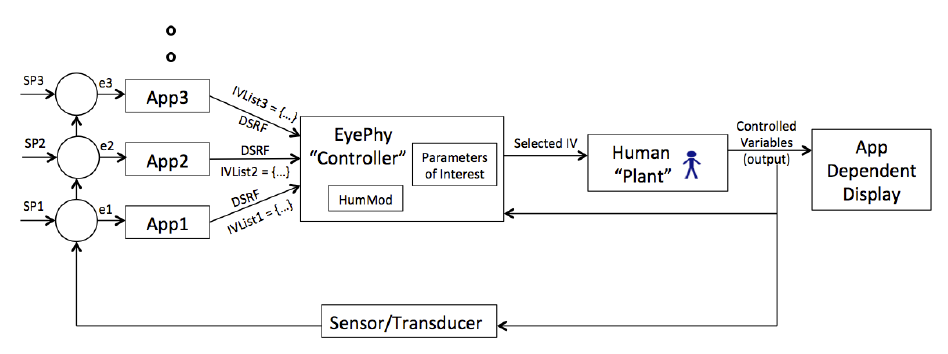
Figure 1: Runtime Dependency Detection by